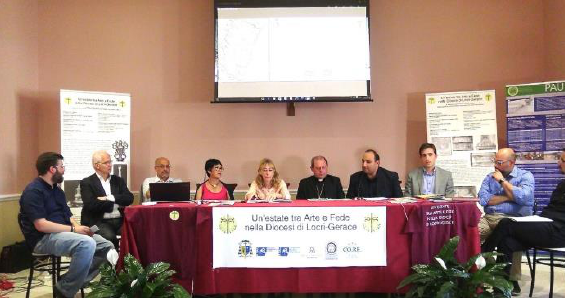
Figure 12. I ntroductory press conference, Gerace, July 4 th , 2016.